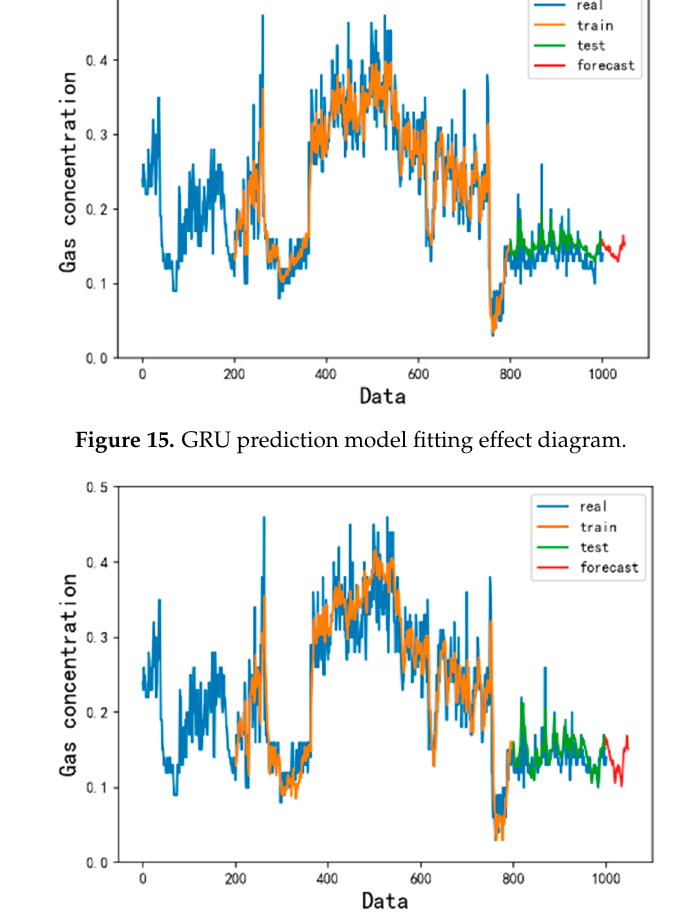
Energies 2019 , 12 , x FOR PEER REVIEW Figure 16. BidirectionRNN prediction model fitting effect diagram. Figure 16. BidirectionRNN prediction model fitting effect diagram. Figure 16. BidirectionRNN prediction model fitting effect diagram.